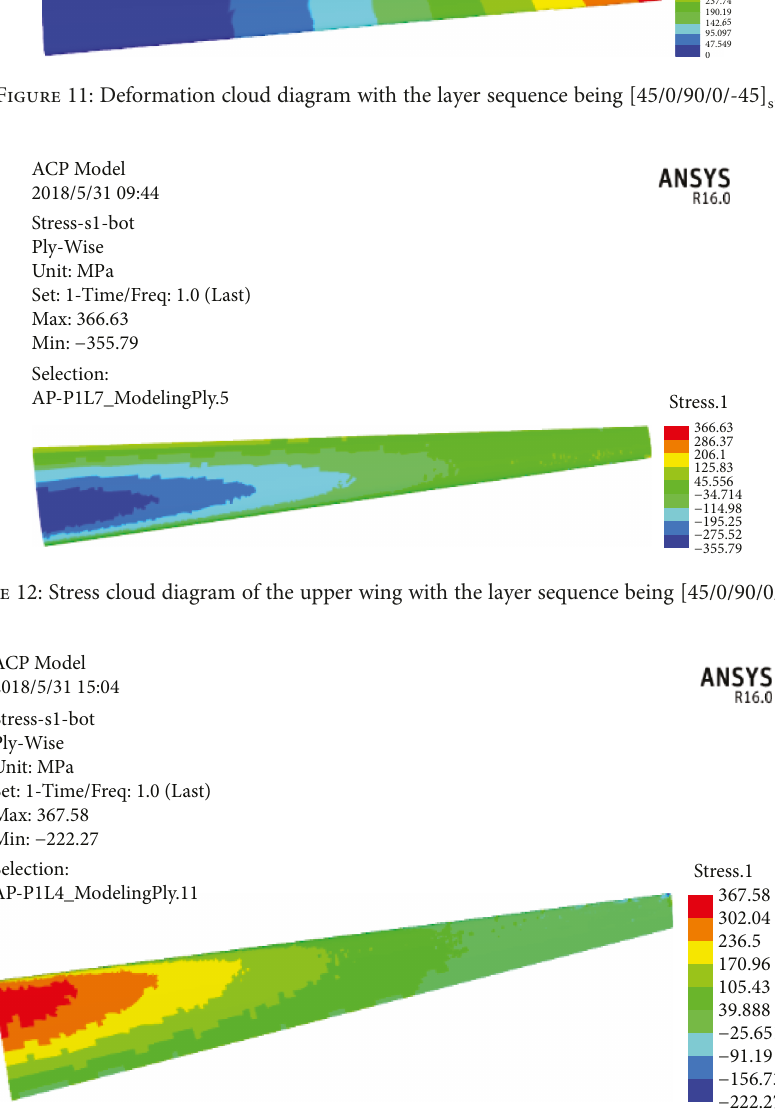
Figure 13: Stress cloud diagram of the lower wing with the layer sequence being [45/0/90/0/-45]